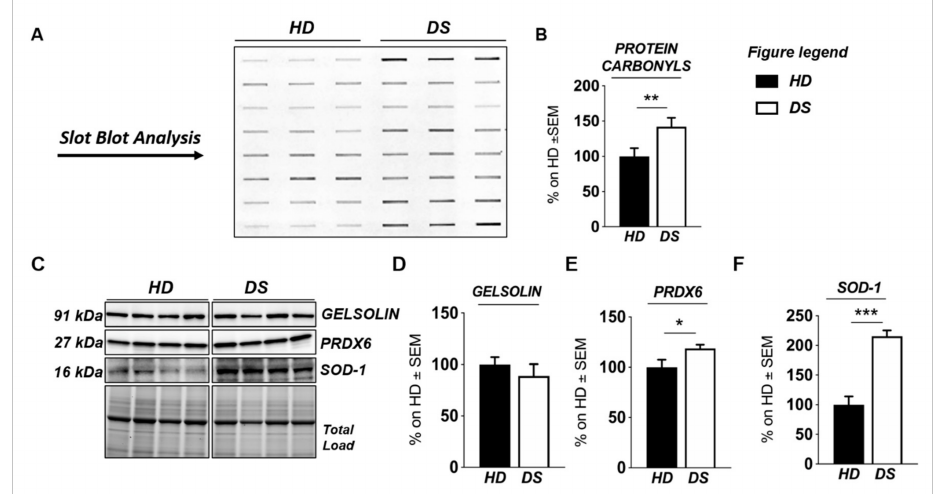
Figure 4. Human PBMCs from DS individuals show the induction of antioxidant responses to counteract OS. Slot blot analysis of total protein carbonylation. Panel ( A ) (left hand side): Slot blot of representative samples from healthy donors (HD) and Down syndrome (DS) groups. A triplicate of eight samples per group is showed. Panel ( B ) (right hand side): Densitometric analysis of total protein carbonylation in healthy donors (HD) and Down syndrome (DS) groups. ( C ) Representative Western blot showing SOD-1, PRDX6, and GELSOLIN in PBMCs from DS and HD. ( D ) Quantification of panel C showing levels of total GELSOLIN. ( E ) Quantification of panel C showing levels of PRDX6 ( E ) Quantification of panel C showing levels of total GELSOLIN. ( F ) Quantification of panel (C) showing levels of SOD1. Densitometric values shown in the bar graph are the mean of six samples for each group normalized for total load and are given as percentage of HD, set as 100%. Statistical significance was determined using Student t-test analysis (* p < 0.05, ** p < 0.01, *** p < 0.001).